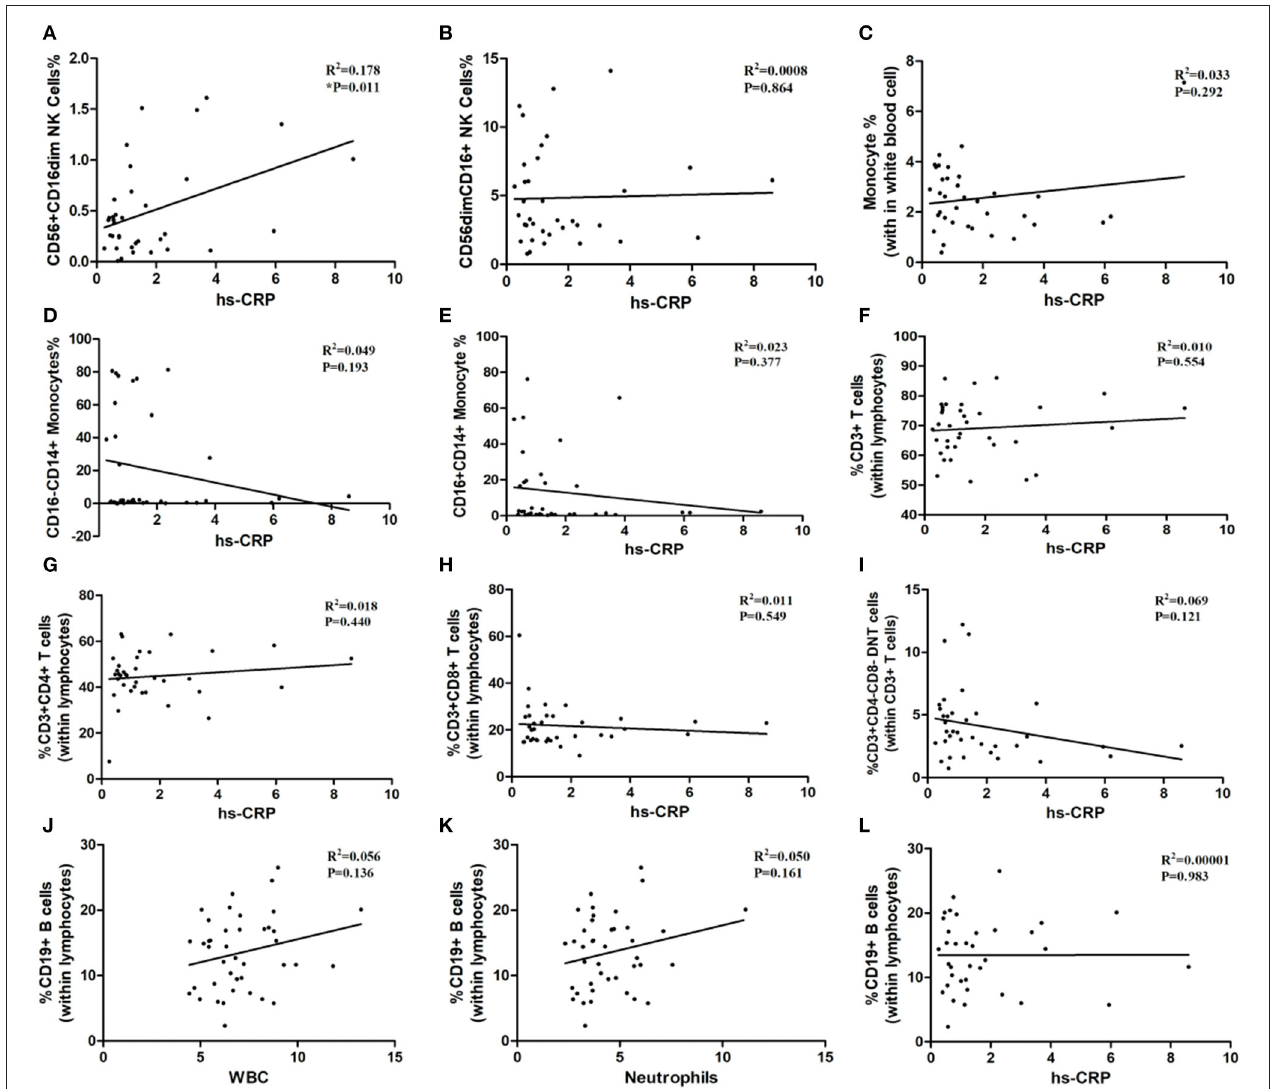
FIGURE 8 | The correlation between immune cells and hypersensitive C-reaction protein and the correlation between inflammatory biomarkers and CD19 + B-cells. hs-CRP: hypersensitive C-reaction protein. (A) CD56 + CD16dim NK cells. (B) CD56 dim CD16 + NK cells. (C) Monocytes. (D) CD16 − CD14 + Monocytes. (E) CD16 + CD14 + Monocytes. (F) CD3 + T-Cells. (G) CD3 + CD4 + T-Cells. (H) CD3 + CD8 + T-Cells. (I) CD3 + CD4 − CD8 − T cells. (J–L) the correlation between WBC, neutrophils, hs-CRP and CD19 +